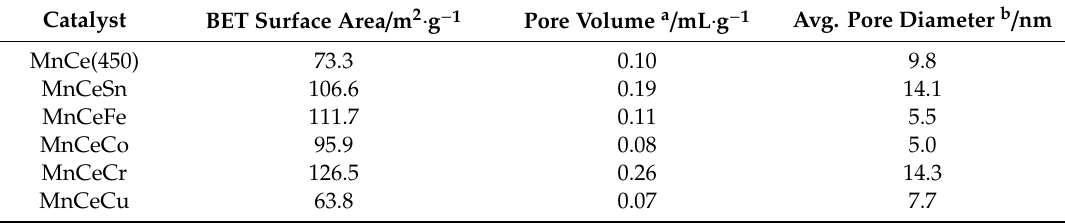
Table 2. Textural properties of MnO x -CeO 2 based